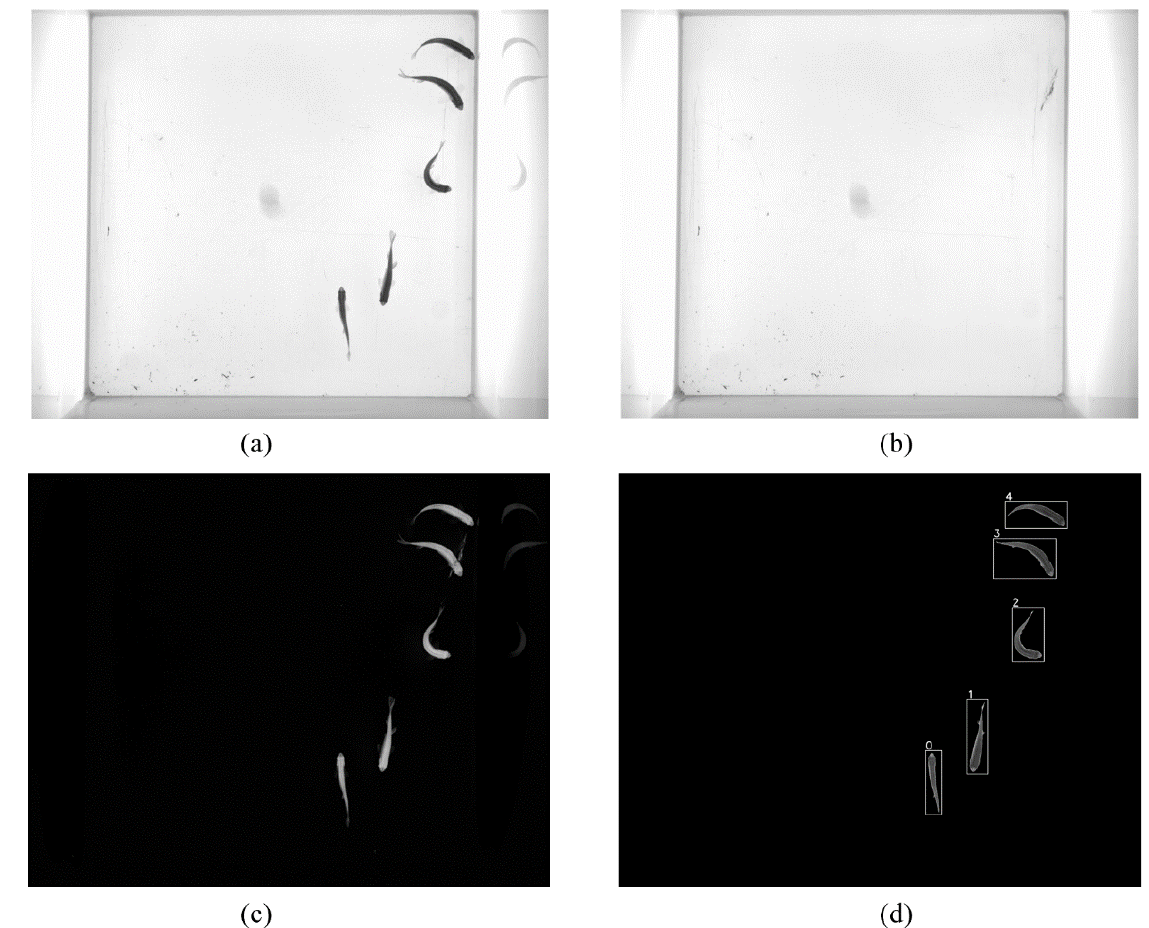
Figure 2. Fish segmentation process, ( a ) original image, ( b ) background image, ( c ) differential image, ( d ) blob detection and bounding boxes.